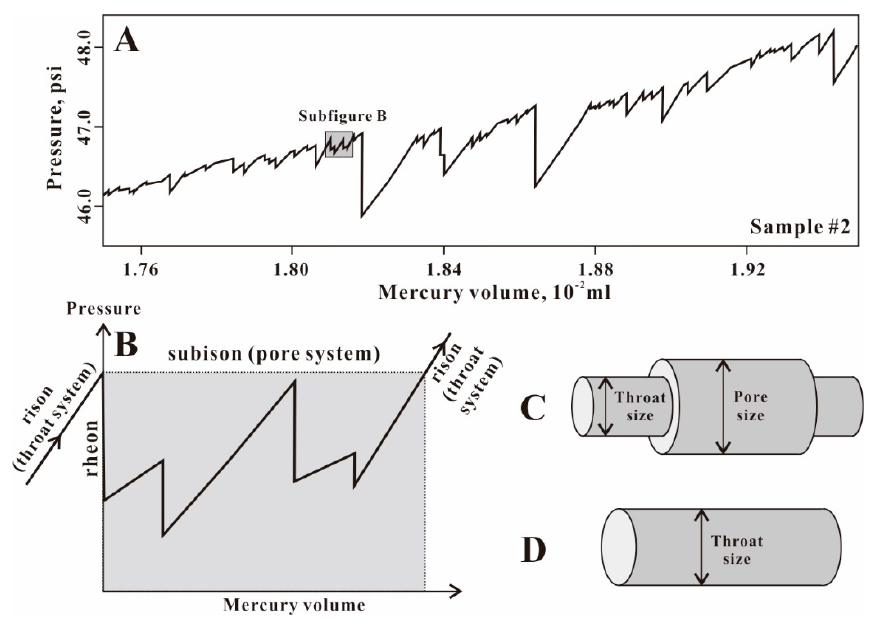
Figure 2. A small piece of raw RMIP data for sample #2 ( A ), mercury intrusion process analysis of RMIP ( B ), and the pore-throat structure models assumed in RMIP ( C ) and PMIP (pressure-controlled mercury intrusion porosimetry) ( D ) methods, respectively.